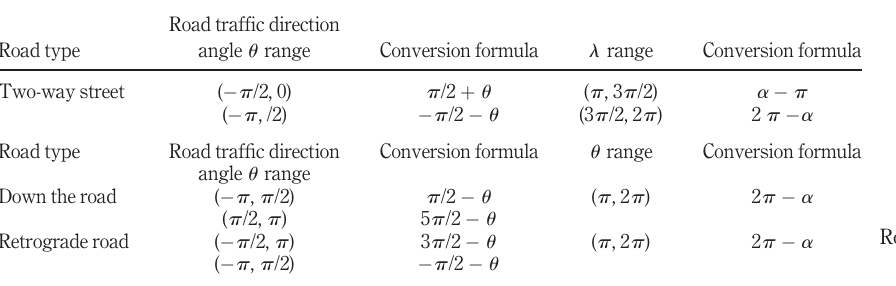
Table I. Road traf fi c